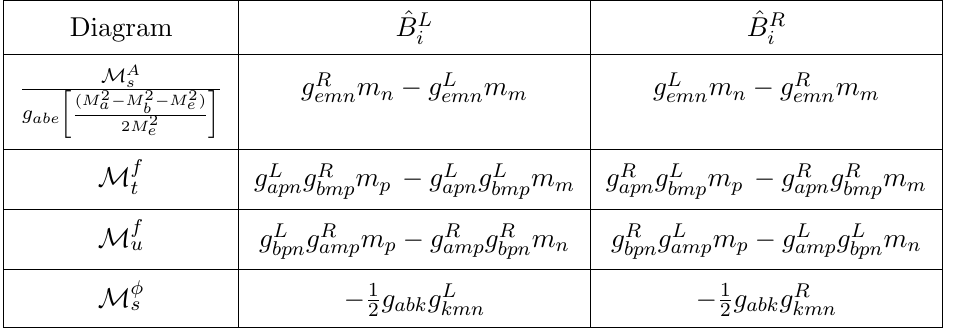
Table 3 . Coe(cid:14)cients ^ B i